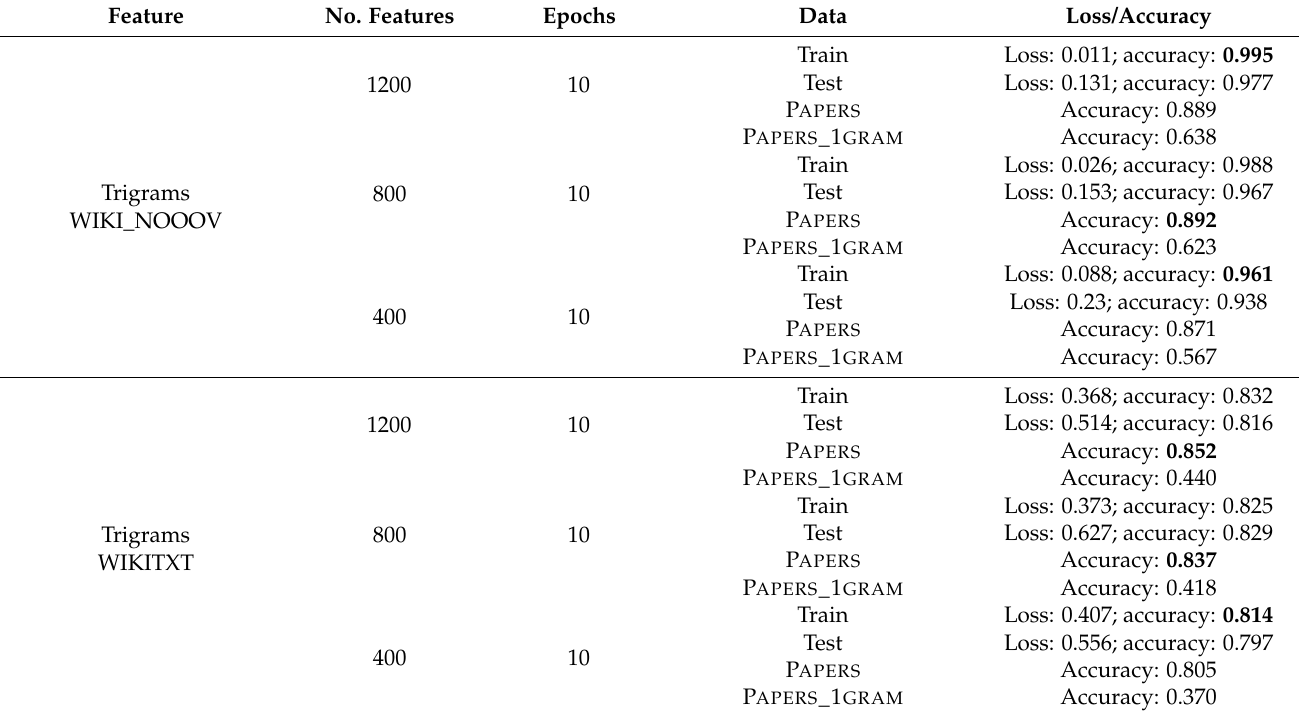
Table 5. Accuracy values for ANN